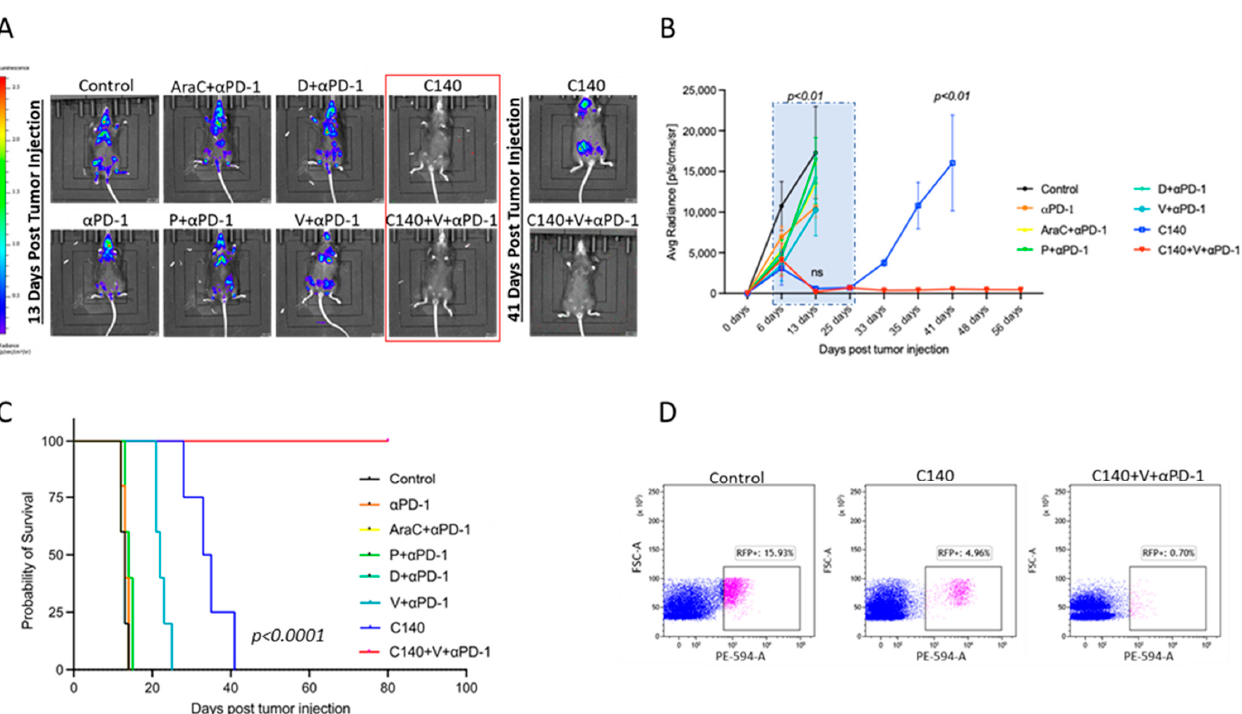
Figure 2. Ly27085-Luc lymphoma growth control by TT vs. other therapies. ( A ) In vivo live imaging of Ly27805-Luc tumors of mice treated with different experimental conditions. On the left is shown the luminescence/radiance bar. Red indicates a higher luminescence signal while blue is the lowest one. Mice were injected with 1 × 10 5 Ly27805-Luc cells and monitored by IVIS. Images were taken 13 days after tumor injection. Mice in the red square did not show any difference, thus the mice were monitored for a longer period. On the right is shown the image 41 days after tumor injection. ( B ) Ly27085-Luc tumor growth curve of mice treated with chemotherapeutic agents, ICI, or chemotherapeutic agents combined with ICI. The dashed blue square represents the treatment period (from day 7 until day 28 post lymphoma injection). The Shapiro–Wilk test was performed to define normal distribution, and a 2-tail T Student’s test was applied. Statistical analysis was done for each condition compared with C140+V+anti-PD-1 (n = 5 per experimental condition). ( C ) Kaplan-Meier survival analysis of Ly27085-Luc-injected mice treated with chemotherapeutic agents, ICI, or chemotherapeutic agents combined with ICI. The Mantel-Cox test was performed to assess statistical differences in survival between the three groups (n = 5 per experimental condition). ( D ) Representative flow cytometry plots showing the percentage of RFP + cells within the spleen of a control (left panel), C140- (middle) and C140+V+anti-PD-1-treated mouse. Cells were gated according to physical parameters.